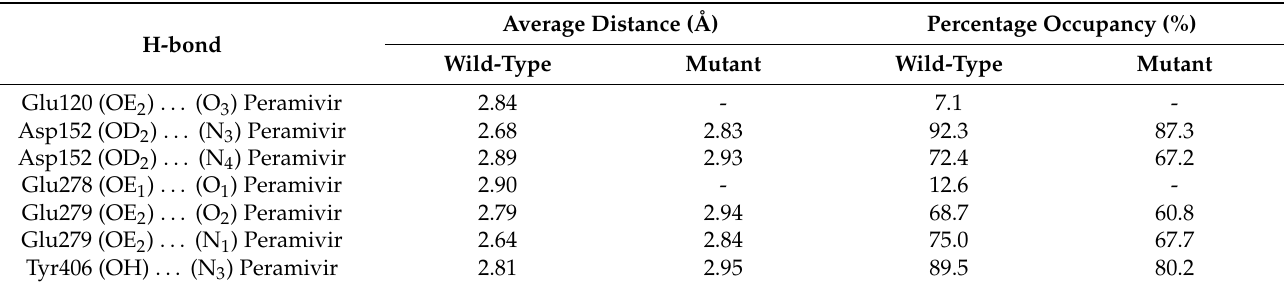
Table 2. Average hydrogen bond distances and percentage occupancy between amino acid residues interacting with peramivir calculated over the simulation